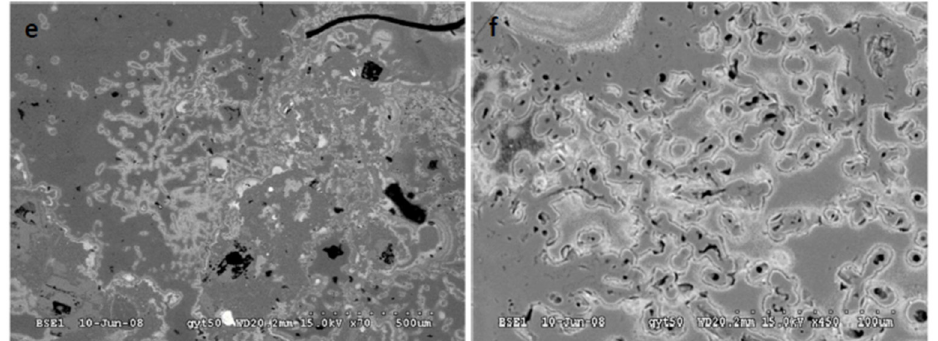
Figure 6. Microbial filamentous forms on EPMA and OM: similar part, similar magnification; the EPMA magnification is increased from Ref. [91], with permission of copyright holder. The biomineralization occurred on altered andesite. ( a ) Microbial filamentous forms on EPMA BEI image; ( b ) Same part on OM, transmitted light, 1N; ( c ) OM image, transmitted light, 1N; ( d–f ) microbial filamentous forms on EPMA BEI image of the same part, magnification is increasing. The greenish- yellow haloes around the filaments are mineralized extracellular polymeric substances (EPSs), which are not visible on BEI images.